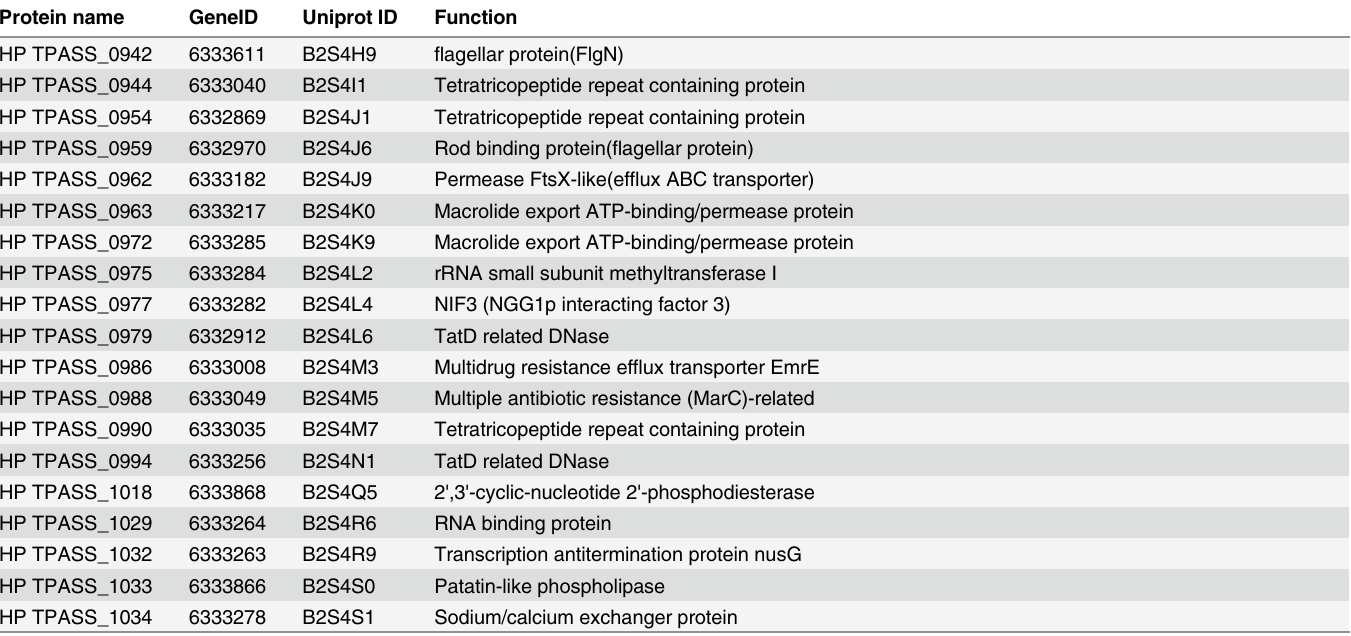
protein which is found in penicillin binding proteins and serine/threonine kinases [34]. McKe- vitt et al., [35] in their study of T . pallidum ssp . pallidum (Nichols strain) antigens predicted